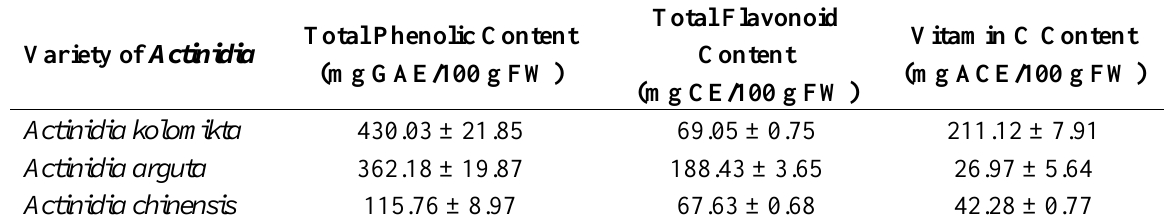
Table 1. Total phenolic, total flavonoid and vitamin C contents of Actinidia